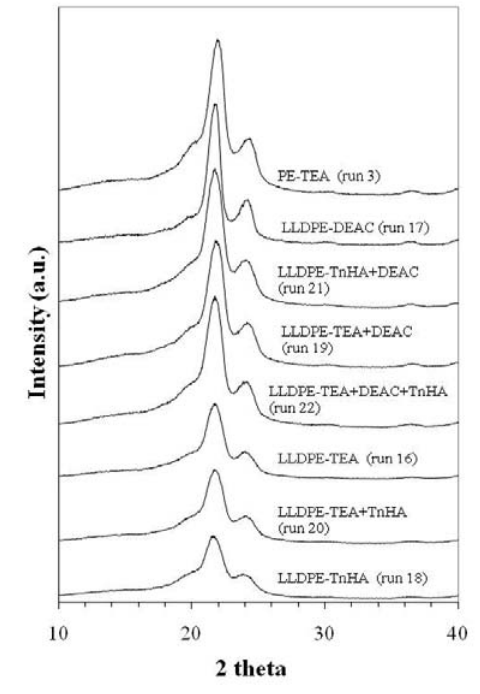
Figure 5. XRD patterns of PE and EH copolymers obtained with various